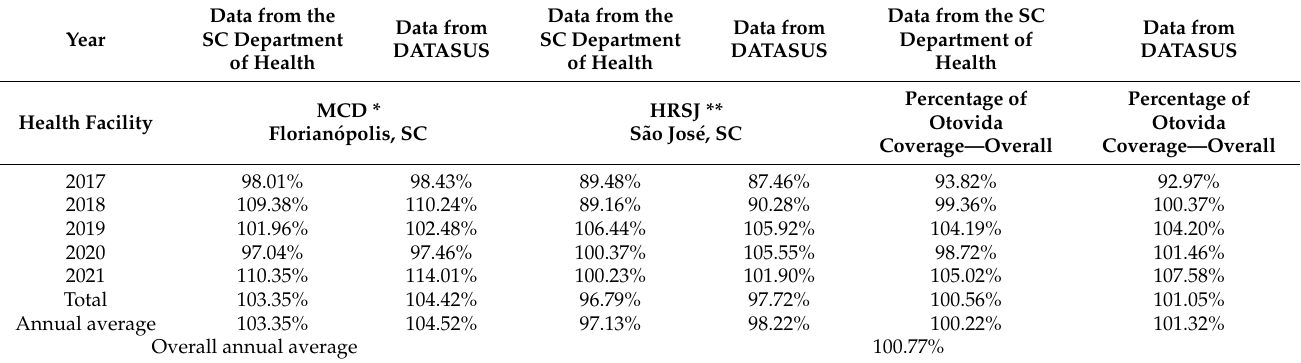
Table 1. Analysis of the number of visits (screenings performed) and percentage of those screened of the number of live births, obtained from the websites of the Ministry of Health, TabNet (DATASUS— visits performed), and the State Department of Health in the two maternity hospitals. Florian ó polis, SC (2017 to 2021).